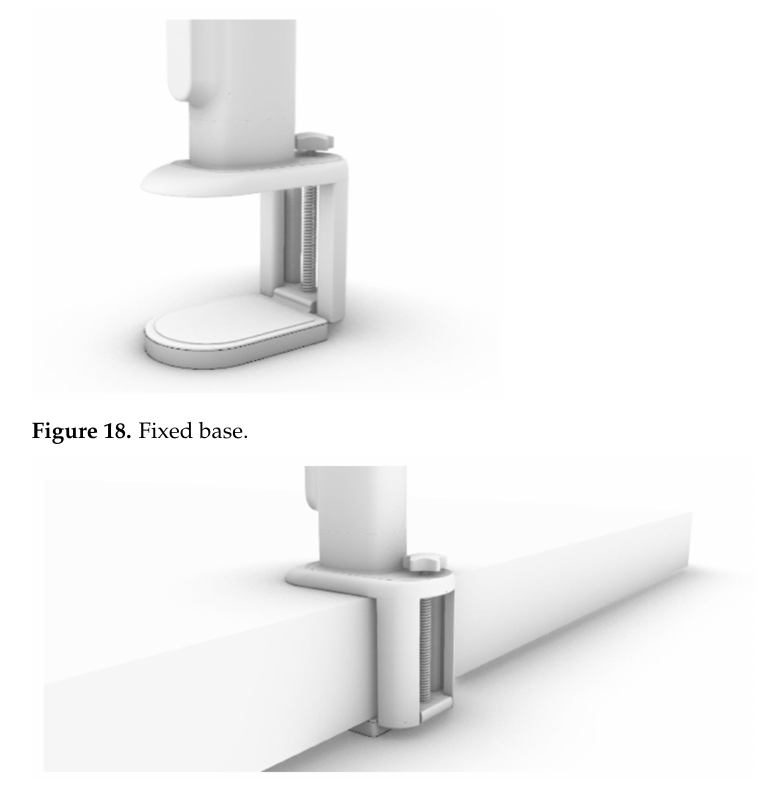
Figure 19. Fixed with desk.